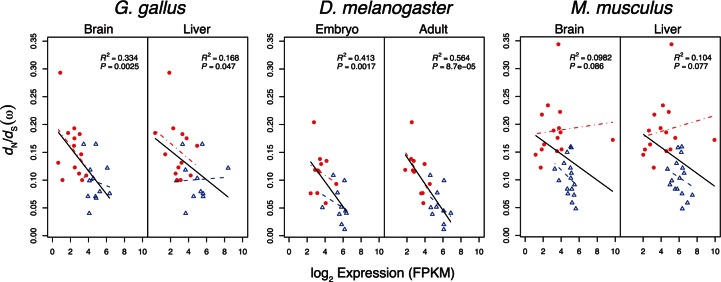
The relationship between transcript level (FPKM) and dN/dS (ω) for aaRS genes. A significant negative relationship exists between FPKM and dN/dS in chicken and D. melanogaster, but not in mouse. GLM regression lines are shown separately for mt-aaRS (closed circles, red dash-dot line) and cyt-aaRS (open triangles, blue dashed line) and for all aaRS genes (solid black line). R2 and P values are from regressions using data from all aaRS genes.